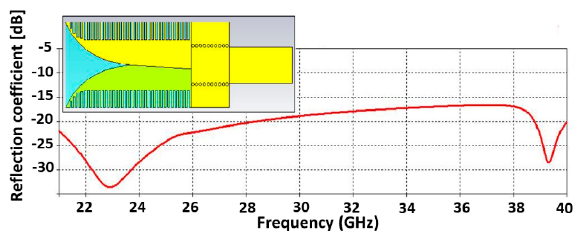
Figure 7. SIW-fed antipodal Vivaldi antenna and its reflection coefficient.